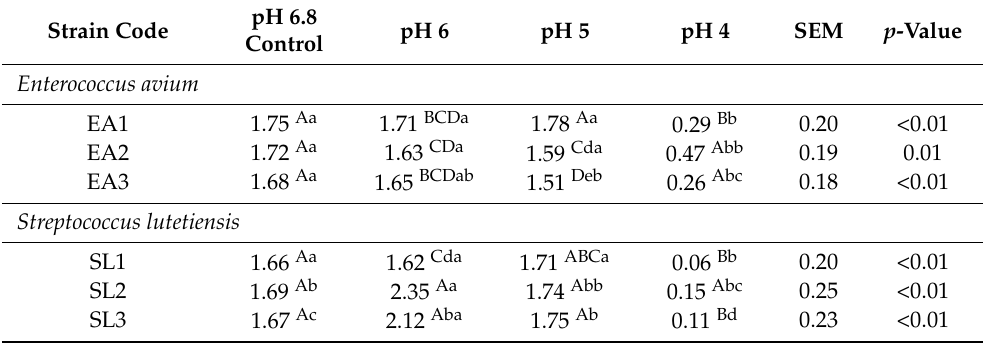
Table 2. Growth (OD600) of Enterococcus avium , Streptococcus lutetiensis and Streptococcus equinus after 24 h of growth in media at different